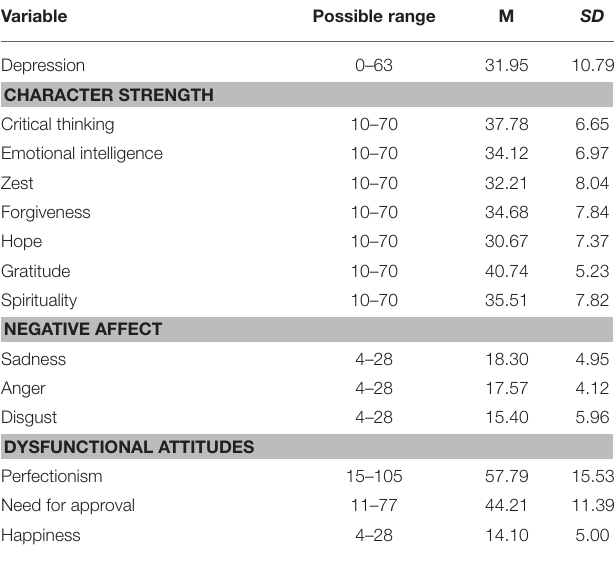
TABLE 1 | Possible score ranges, means and standard deviations of the variables. Variable